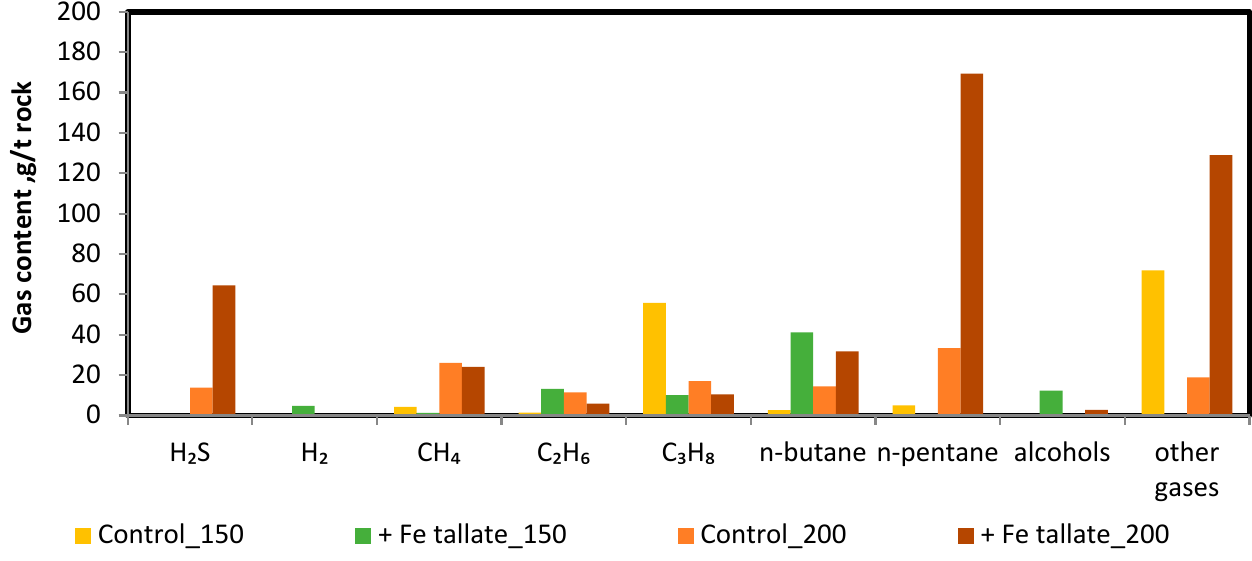
Figure 2. Content and composition of gases (individual gases, alcohols and other gases) depending on TST temperature and the presence of iron tallate.